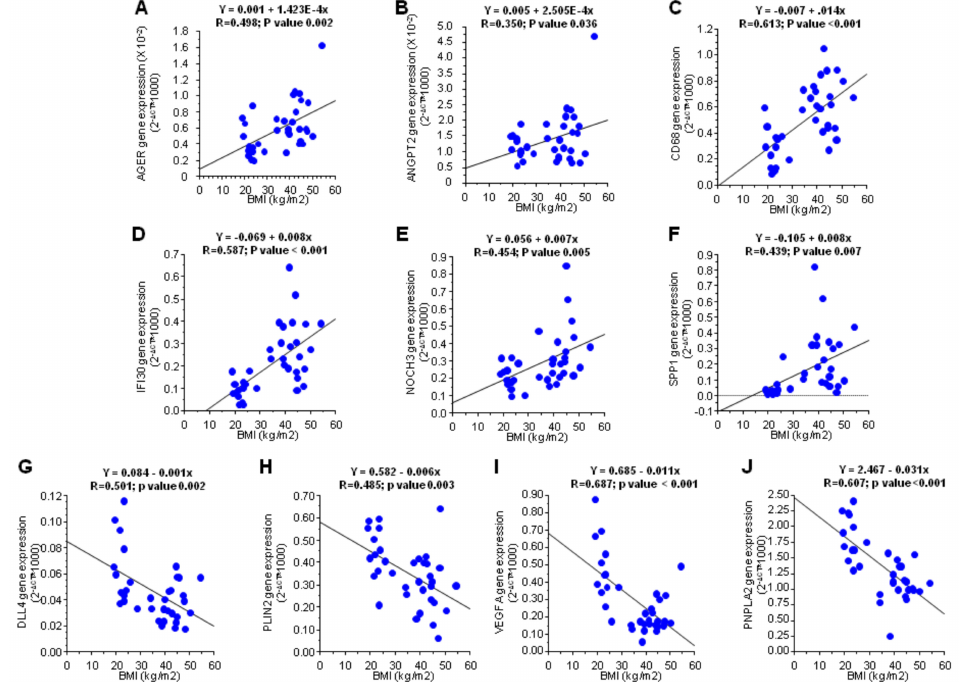
Figure 2. Line regression between expression of validated genes and body mass index (BMI). Correlations were determined by linear correlations. ( A ) Line regression between AGER and body mass index; ( B ) Line regression between ANGPT2 and body mass index; ( C ) Line regression between CD68 and body mass index; ( D ) Line regression between IFI30 and body mass index; ( E ) Line regression between NOCH3 and body mass index; ( F ) Line regression between SPP1 and body mass index; ( G ) Line regression between DLL4 and body mass index; ( H ) Line regression between PLIN2 and body mass index; ( I ) Line regression between VEGFA and body mass index; ( J ) Line regression between PINPLA2 and body mass